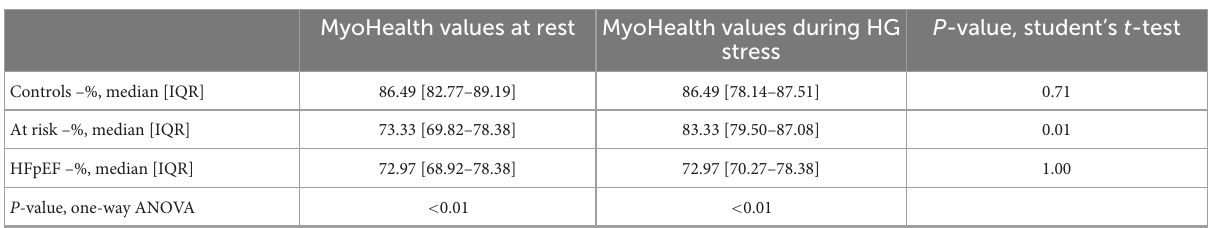
TABLE 2 Comparison of the MyoHealth